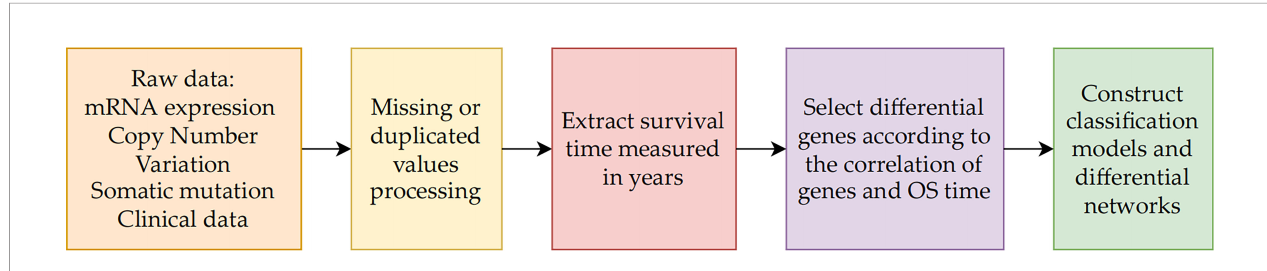
FIGURE 1 | The work fl ow of our